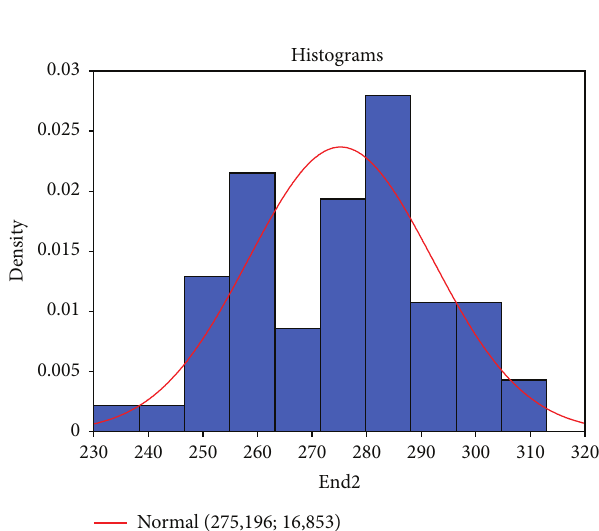
Figure 2: Probability fit with Normal distribution for cessation of light frost in